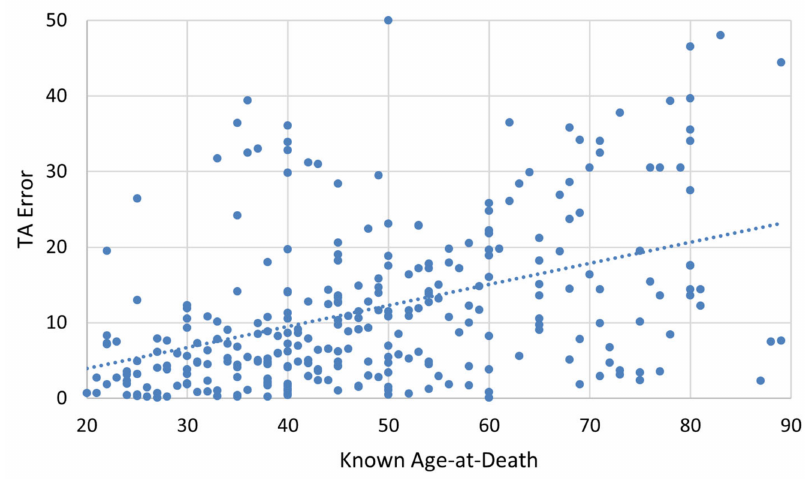
Figure 3. Association between known age-at-death and TA error (in